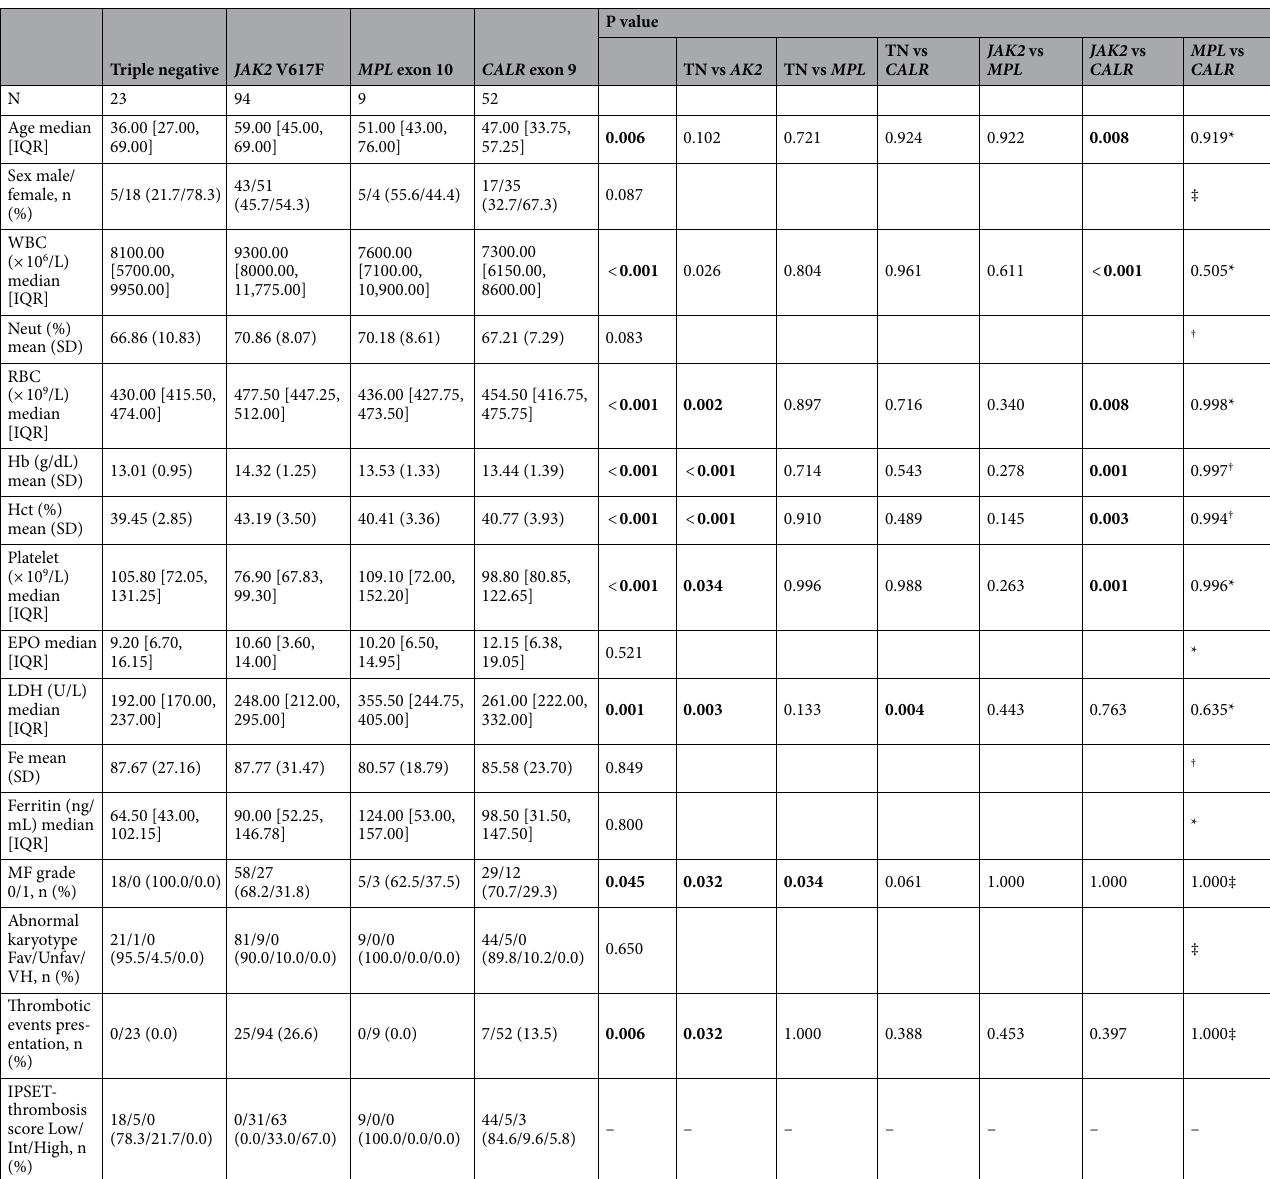
Table 1. Clinical characteristics of the ET patients grouped by driver mutation status. IQR interquartile range, Fav Favorable, Unfav Unfavorable, VH Very High, Int Intermediate. *Kruskal–Wallis test/Steel–Dwass test, † One-way ANOVA/Tukey’s HSD test, ‡Chi-square test/chi-square test with Bonferroni correction. P -values in bold indicate significance (<